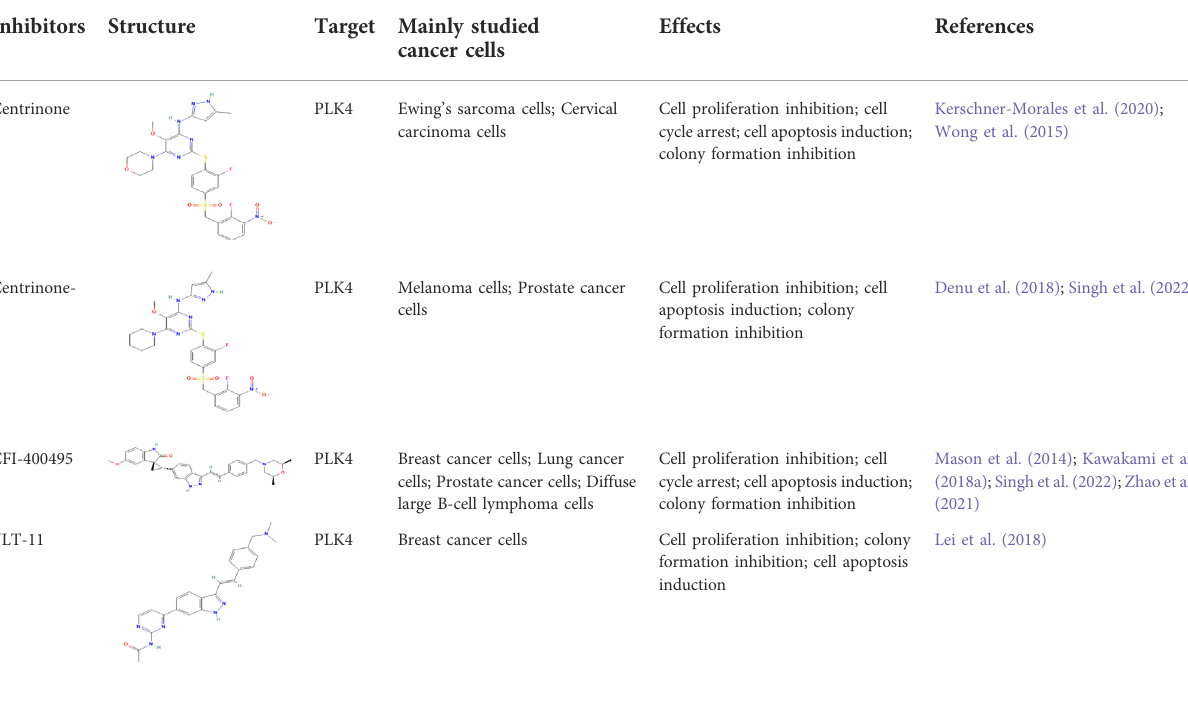
TABLE 1 The summary of the structure, studied cancer cells and roles of the inhibitors of